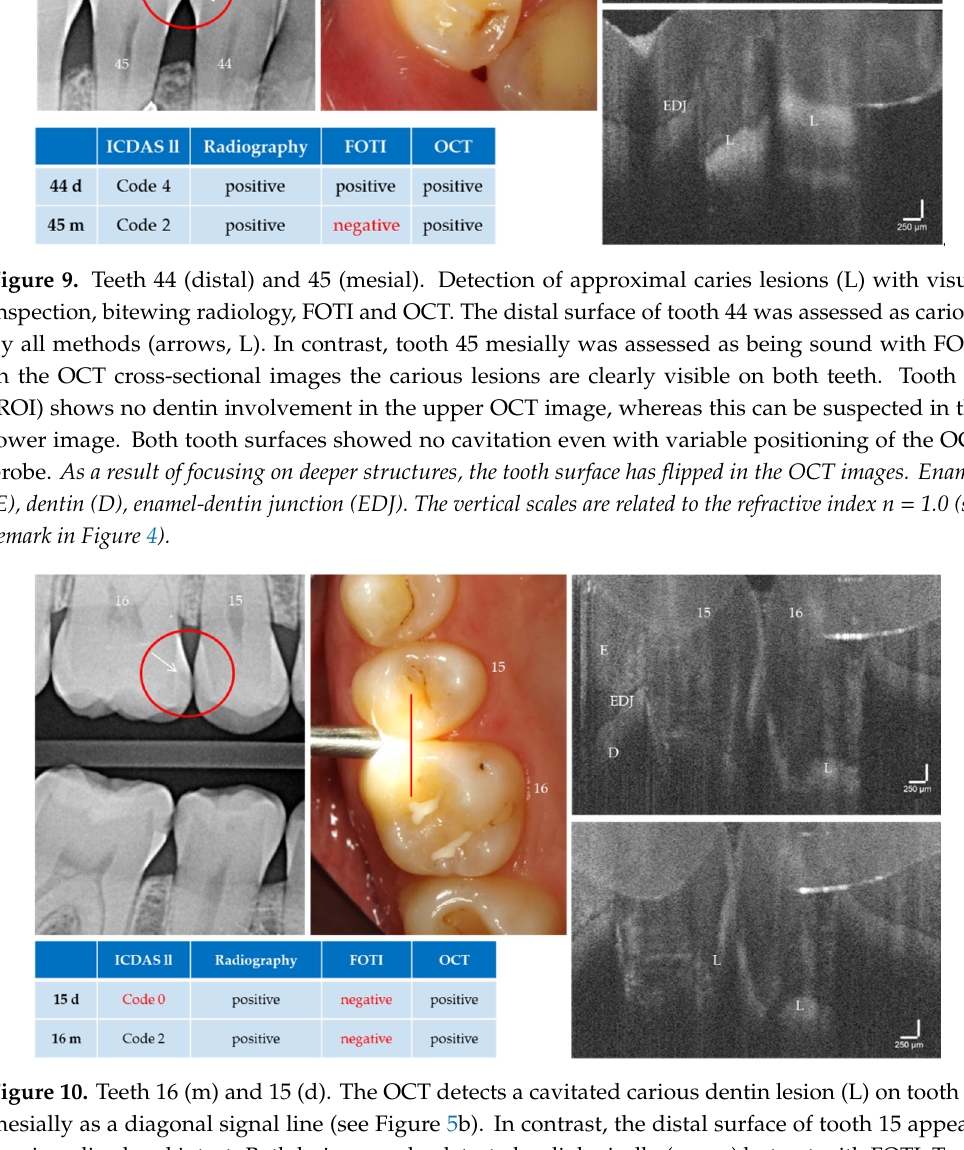
Figure 10. Teeth 16 (m) and 15 (d). The OCT detects a cavitated carious dentin lesion (L) on tooth 16 mesially as a diagonal signal line (see Figure 5b). In contrast, the distal surface of tooth 15 appears demineralized and intact. Both lesions can be detected radiologically (arrow) but not with FOTI. Tooth 15 distal showed no visual evidence of a lesion. As a result of focusing on deeper structures, the tooth surface has flipped in the OCT images. Enamel (E), dentin (D), enamel-dentin junction (EDJ). The vertical scales are related to the refractive index n = 1.0 (see remark in Figure